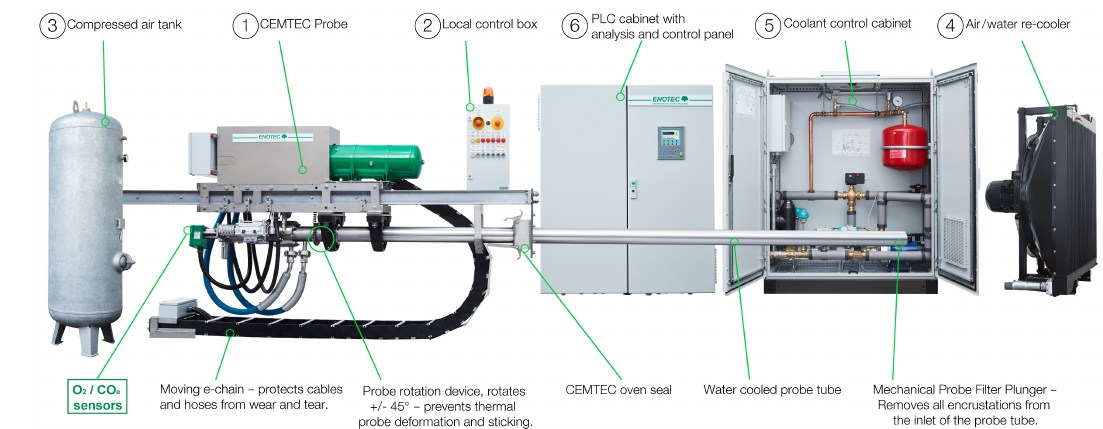
Figure 1. Overview of the CEMTEC gas analysing system with air/coolant re-cooler.